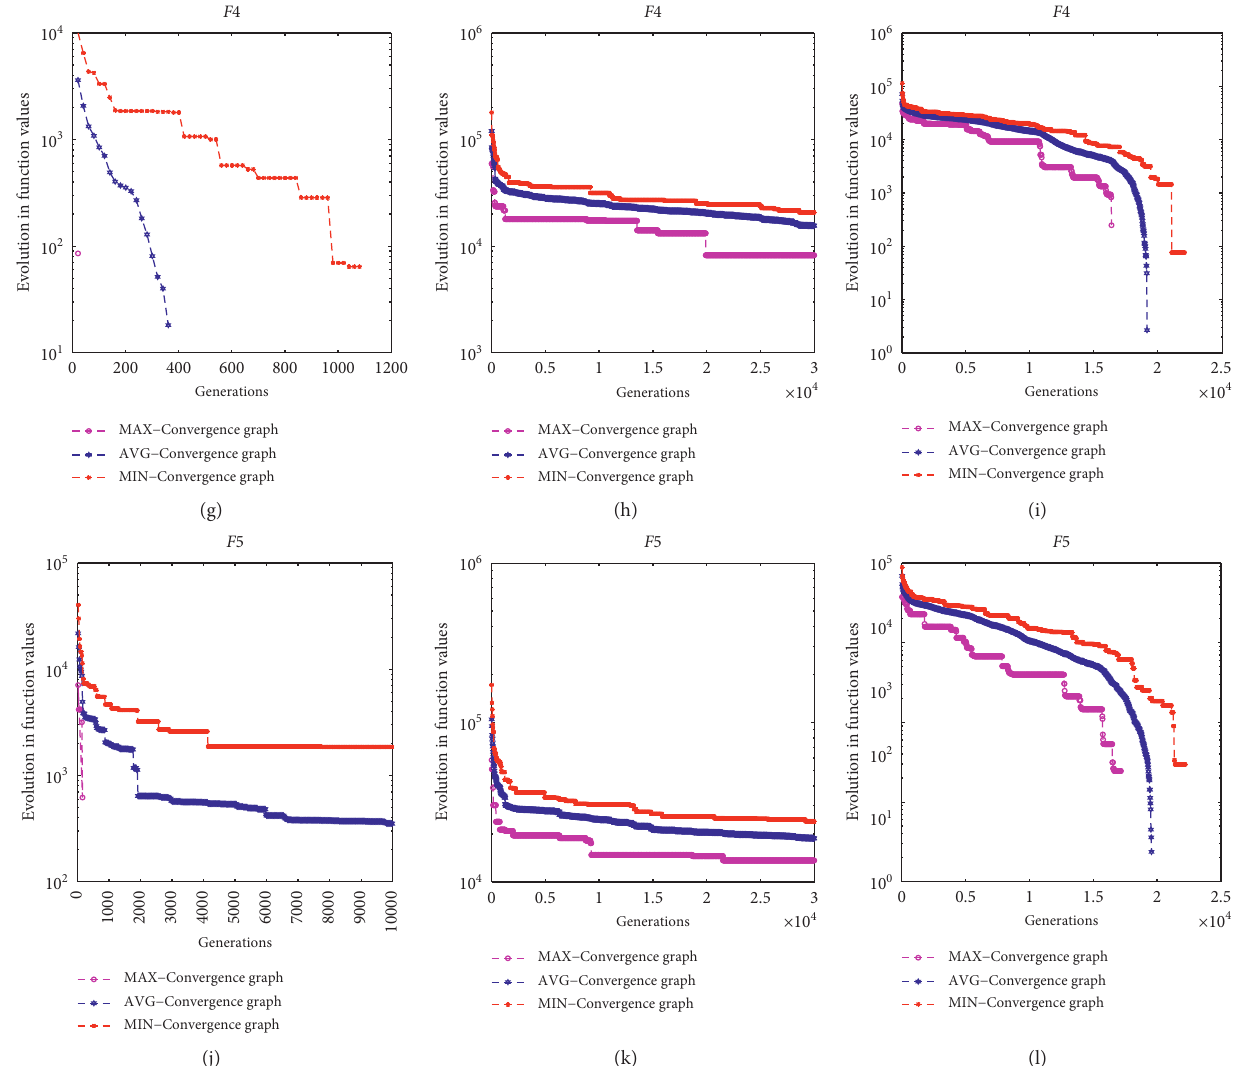
Figure 3: The evolution in maximum, average, and minimum function values displayed by the proposed MSIA solving F functions [54]. The first panel is with respect to n � 10, the second panel is with respect to n � 30, and third panel includes the convergence graphs for n � 50 decision